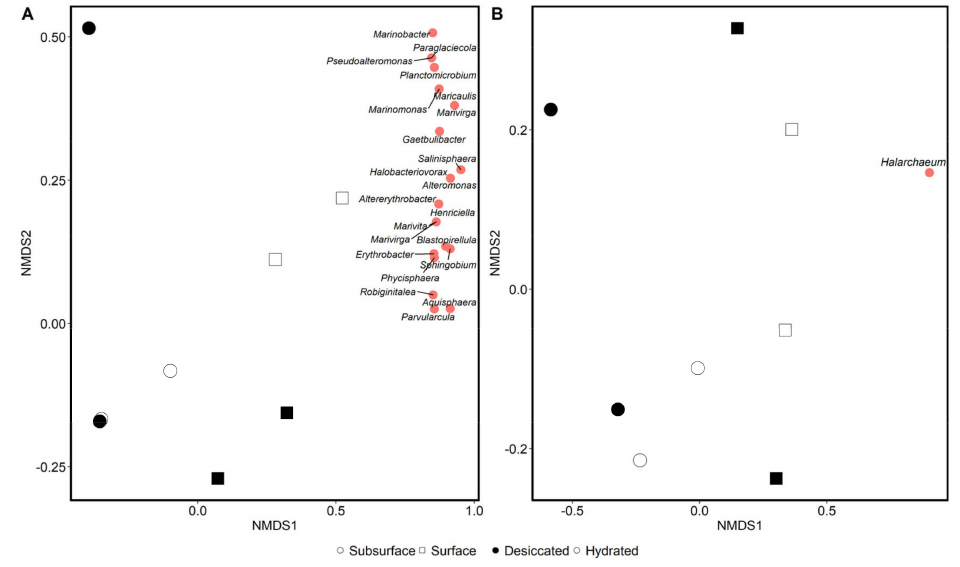
Figure 3. Non-metric multidimensional scaling (NMDS) ordination of bacterial ( A ) and archaeal ( B ) communities in saltpan wetland sediments collected from the Mississippi Gulf Coast. Sediment was collected from the surface and the 30 cm subsurface. Duplicate cores were taken from the same site in a desiccated state and flooded state. Ordinations are based on Bray–Curtis dissimilarity matrices derived from 16S rRNA gene sequence data. Red circles indicate genera that were most influential in separating samples and the position in the NMDS ordination that they pulled samples toward. Only one operational taxonomic unit (OTU) ( Halarchaeum ) was influential in separating archaeal